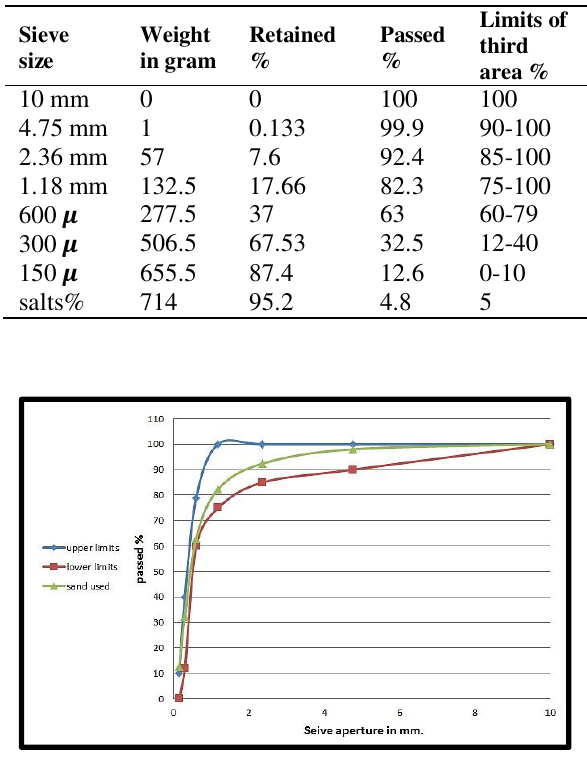
Fig. 1. The upper and lower limits of Iraqi specification and the used